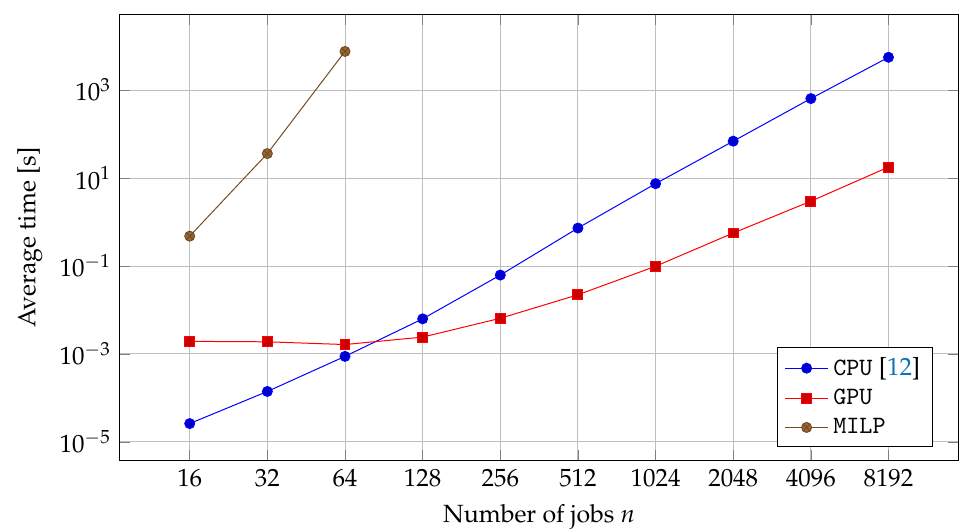
Figure 5. Computation time required to solve CAP instances using different algorithms.